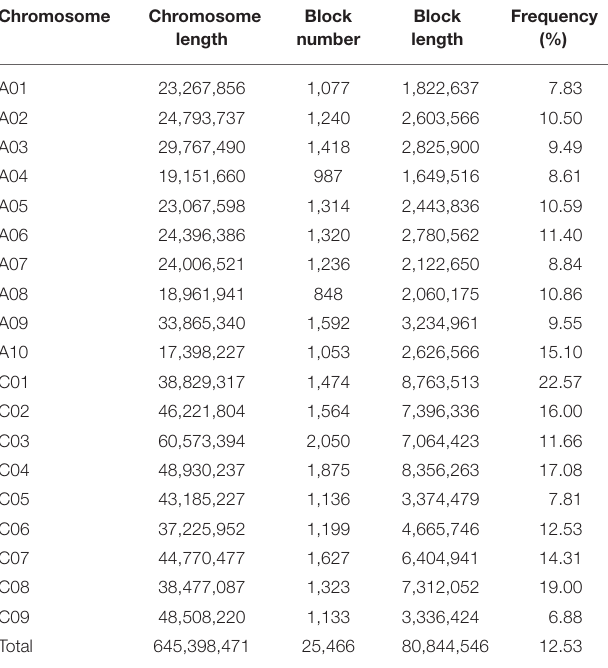
TABLE 3 | Distribution of haplotype blocks in the genome of B. napus. Chromosome Chromosome